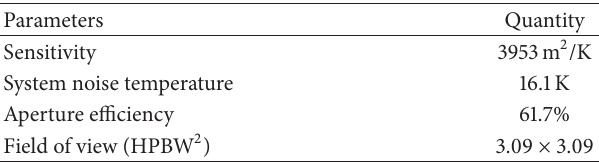
Table 6: Parameters of system performance. Parameters Quantity Sensitivity 3953 m 2 /K System noise